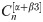
State transition diagram of the Markov model for the BKα+β3 channel.
Cn[α+β3] is the closed state, On[α+β3] is the open state, and In[α+β3] is the inactivation state (n = 1…5); kf, kr, kb, and ku denote transition rates between the states.